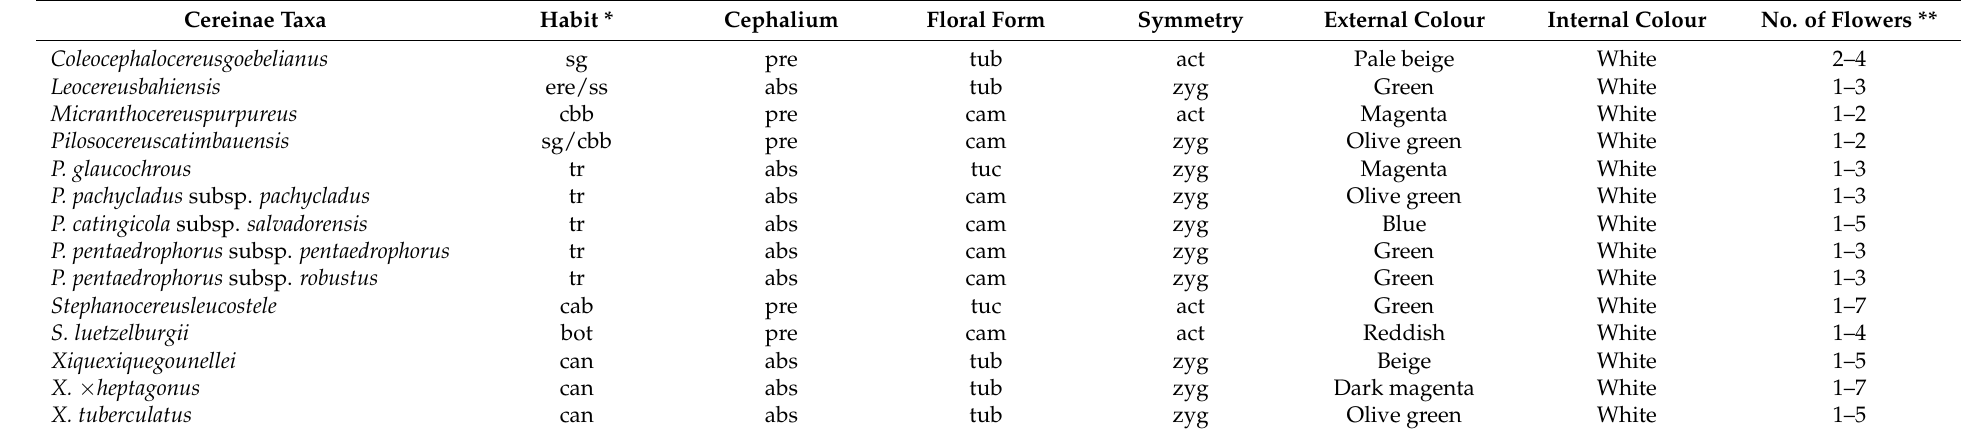
Table 3. Floral biology and attributes of Cereinae (Cactaceae) taxa